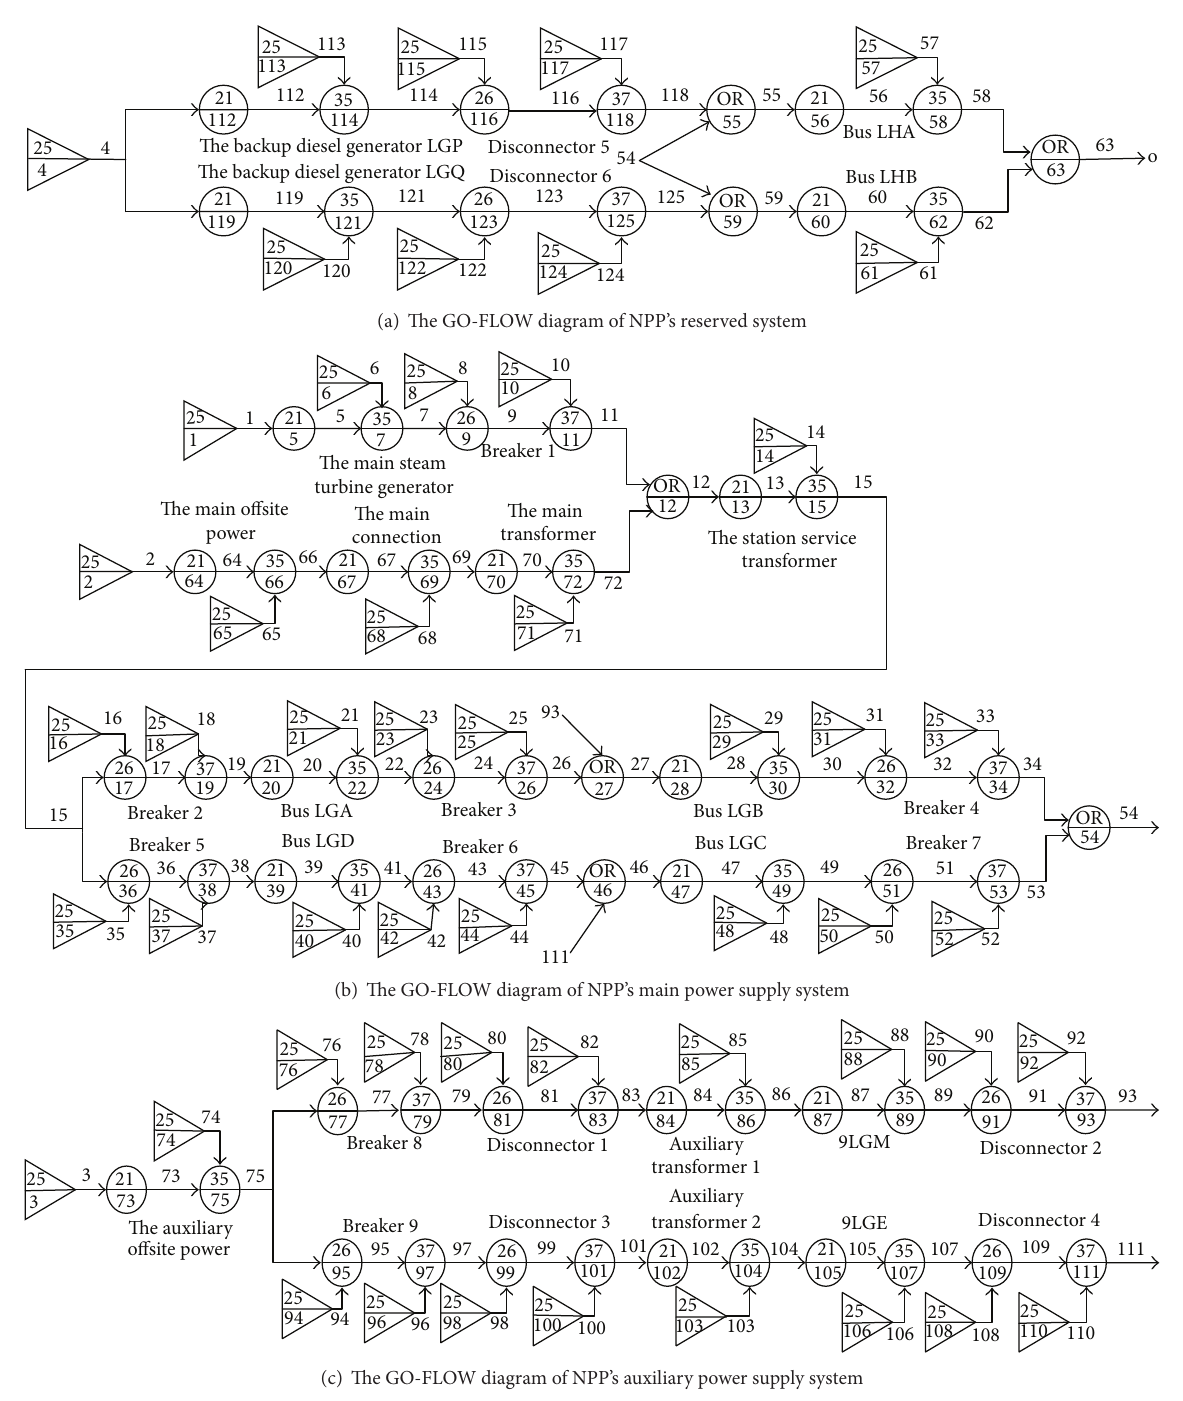
Figure 6: The GO-FLOW diagram of NPP’s power supply